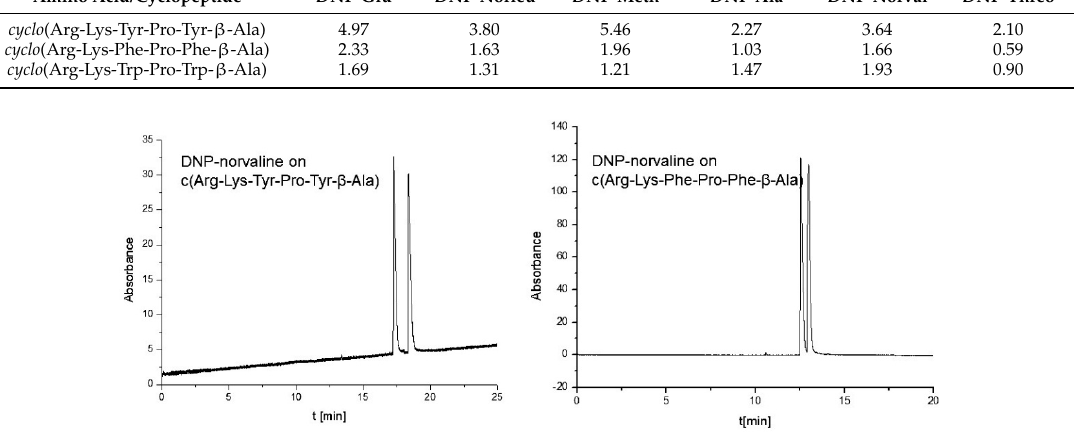
Figure 9. Influence of the change of Tyr for Phe in the cyclohexapeptide for enantioseparation